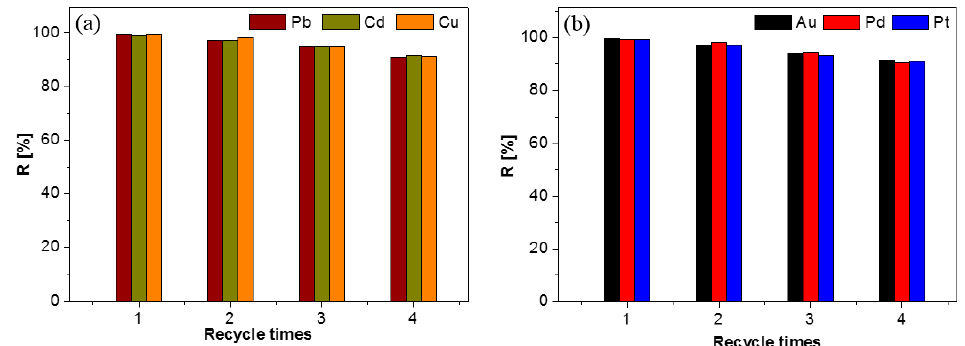
Figure 8. Recyclability of ( a ) DTC-g-PE-DA@GB@PU toward 10.0 μ g mL − 1 Cu 2+ , Pb 2+ and Cd 2+ .